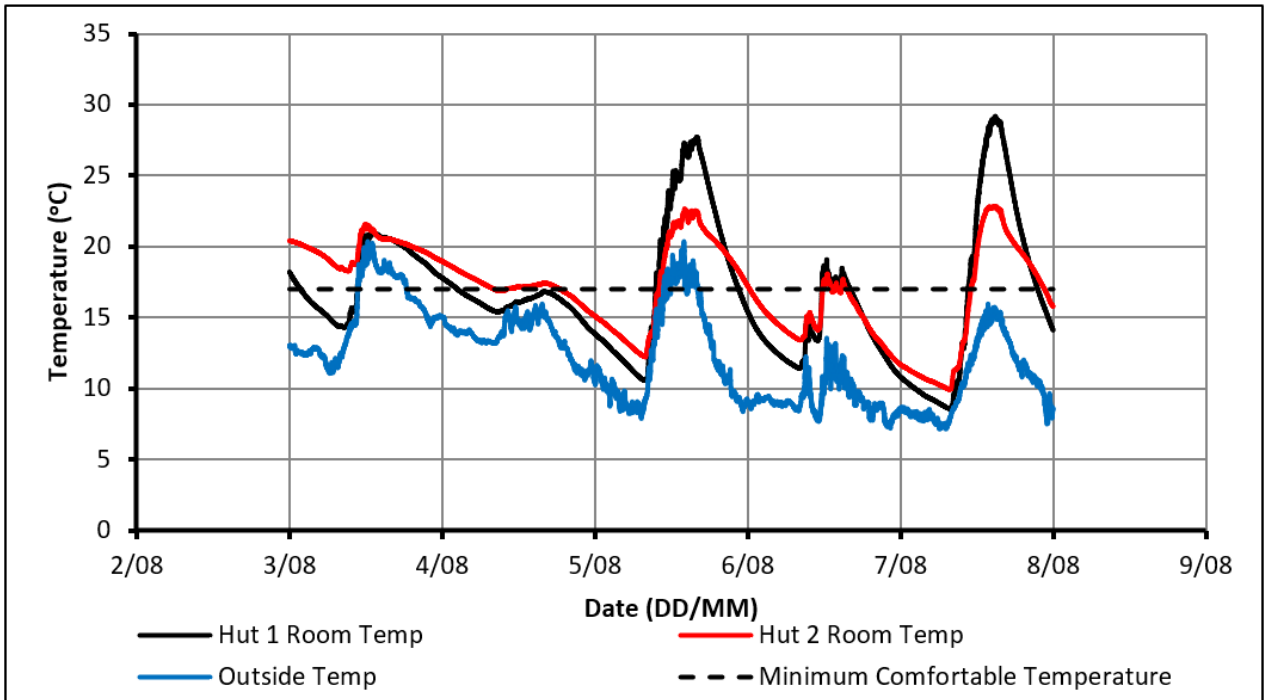
Figure 5. Temperature profiles in case of using passive solar heating and solar air heater.